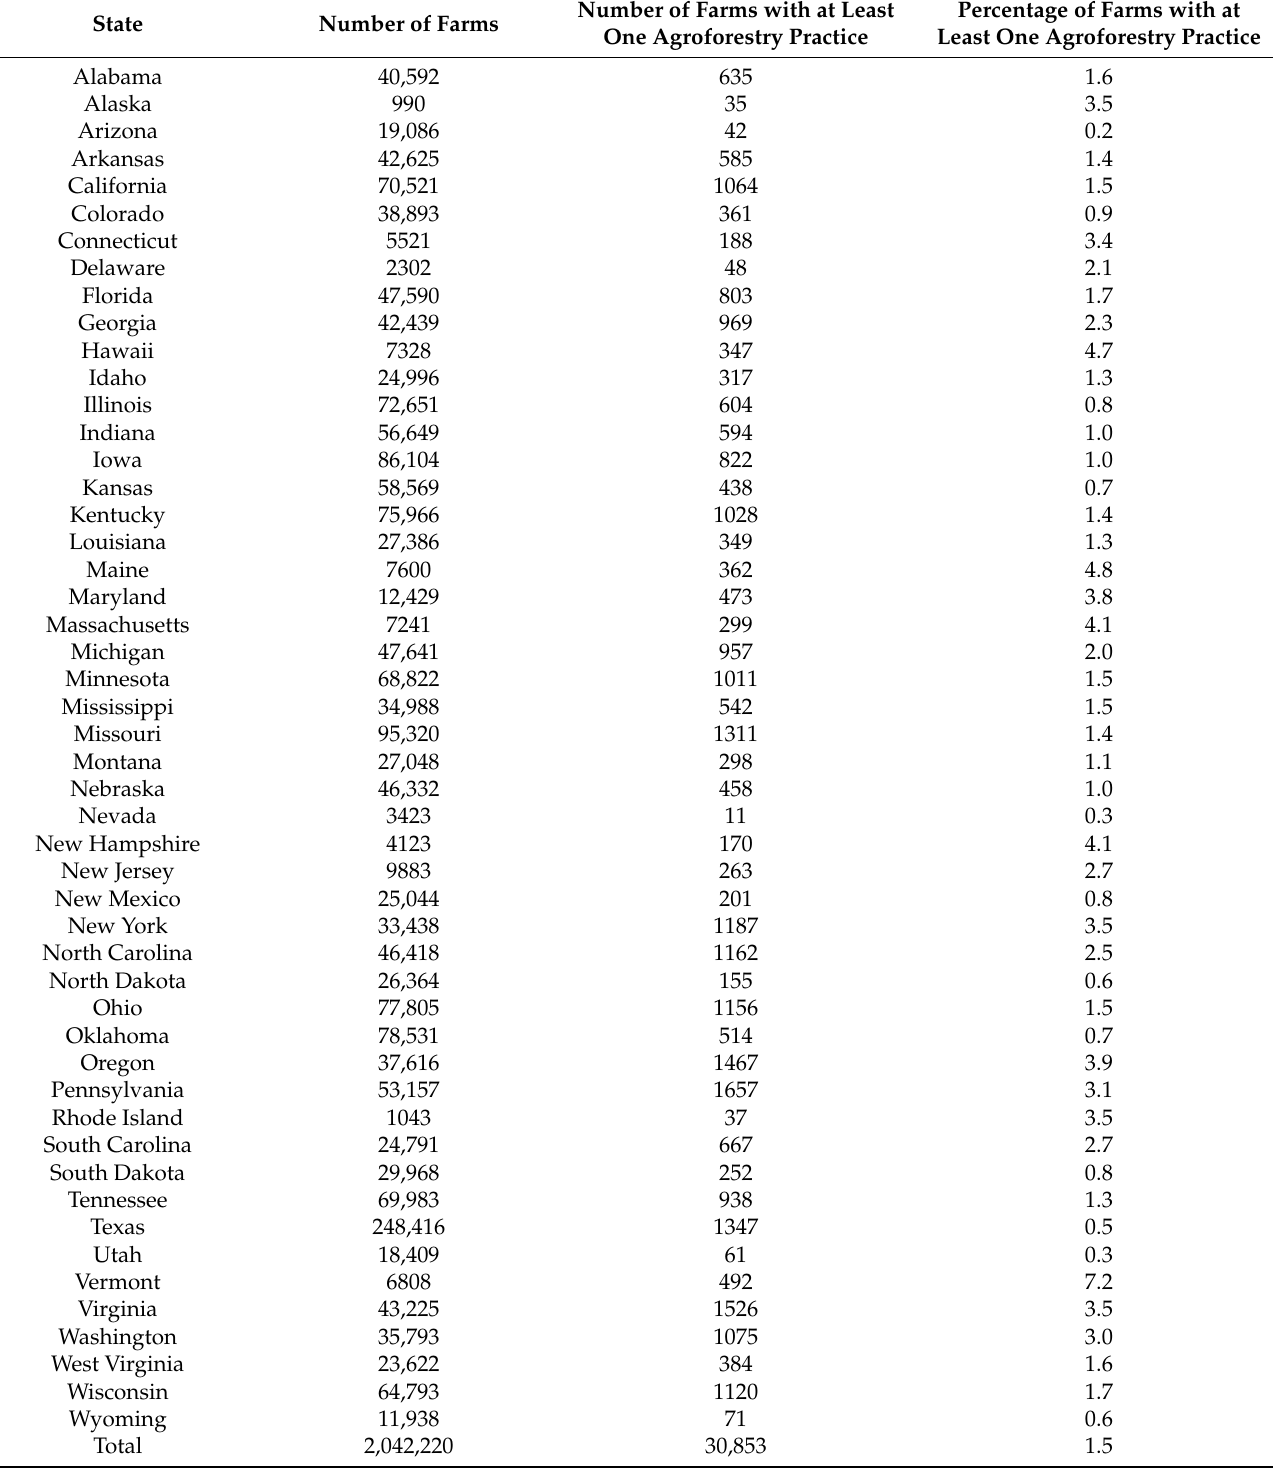
Table 1. Total number of U.S. farms and farms with agroforestry based on the 2017 Census of Agriculture